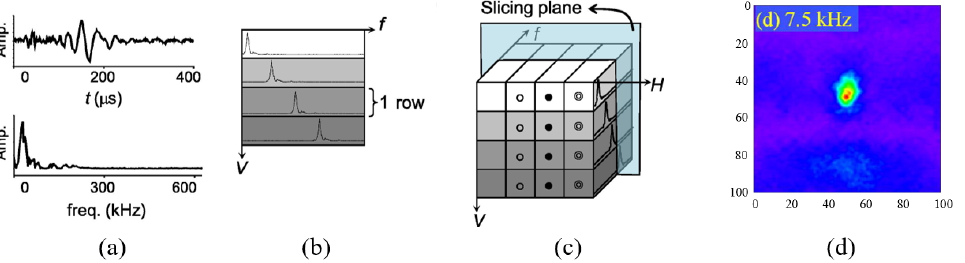
Figure 8. Principle and results of UFT imaging of impact damage in radome. ( a ) Characteristics of Lamb waves in t -domain and f -domain [66]. ( b ) Signals in the t -domain of vertical scan. ( c ) Selected tomogram along the frequency axis. ( d ) Tomogram at a frequency of 7.5